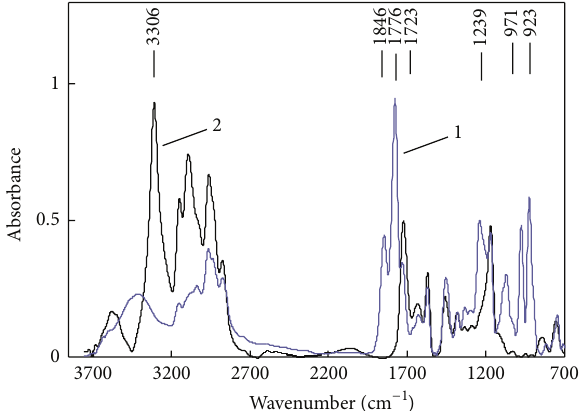
Figure 3: FTIR-spectrum of reaction mixture “1-butyl-3-methyli- midazolium bromide – IMTHPA”: (1) initial mixture; (2) kept for 5 h at 100 ∘ C.